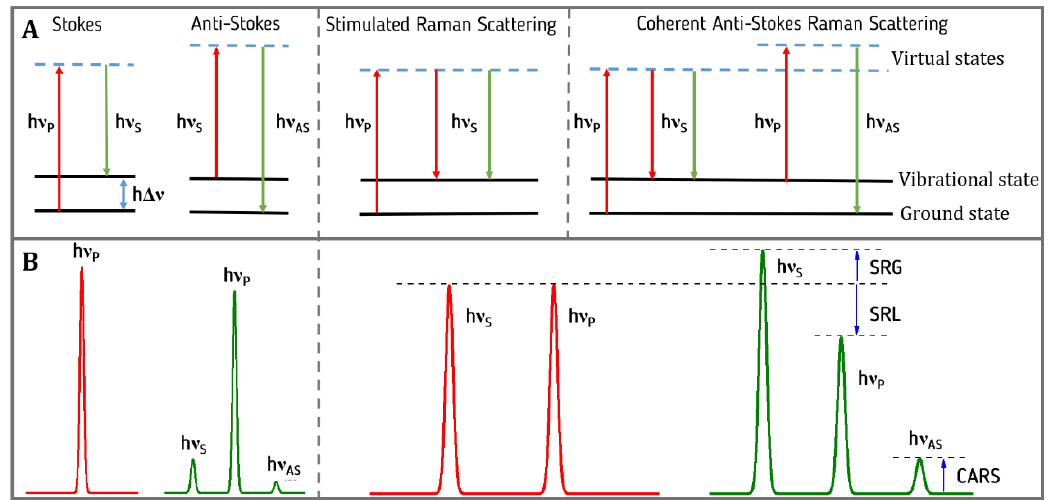
Figure 1. Comparison of the di ff erent Raman scattering methods. ( A ) Energy level diagrams of spontaneous Stokes and anti-Stokes Raman Scattering (on the left), Stimulated Raman Scattering (in the middle) and Coherent Anti-Stokes Raman scattering (on the right). For Stimulated Raman Scattering (SRS) and Coherent Anti-Stokes Raman Scattering (CARS), the case of ν P − ν S = ∆ ν is shown (i.e., ν AS = 2 ν P − ν S ), that corresponds to the coherence condition, where h ∆ ν is an energy di ff erence between the ground state and the first vibrational energy level for selected molecular bond. ( B ) On the left—the spectra of non-scattered (red) and scattered pump laser beam (green) in case of Spontaneous Stokes ( ν S ) and Anti-Stokes ( ν AS ) Raman Scattering. On the right—the spectra of both pump beam ( ν P ), Stokes beam in the case of SRS and anti-Stokes beam in the case of CARS before (red) and after (green) interaction with the sample containing molecules with selected molecular bond.